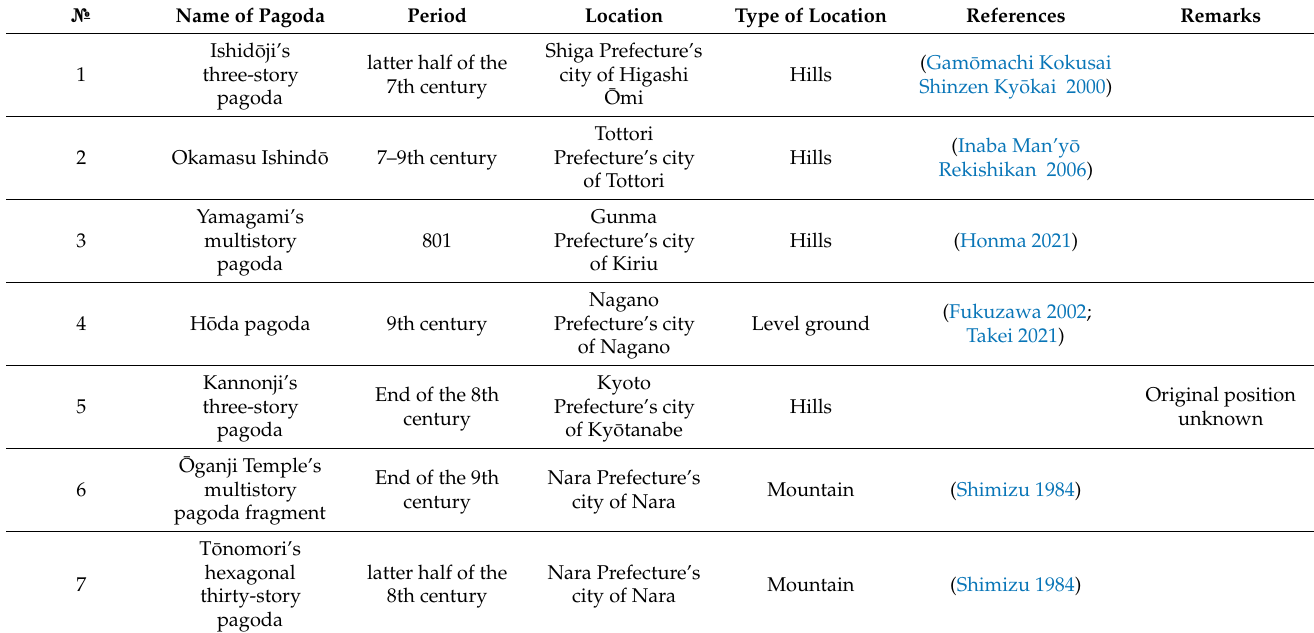
Table 1. Multistory Pagodas from the 7th to 9th Centuries in